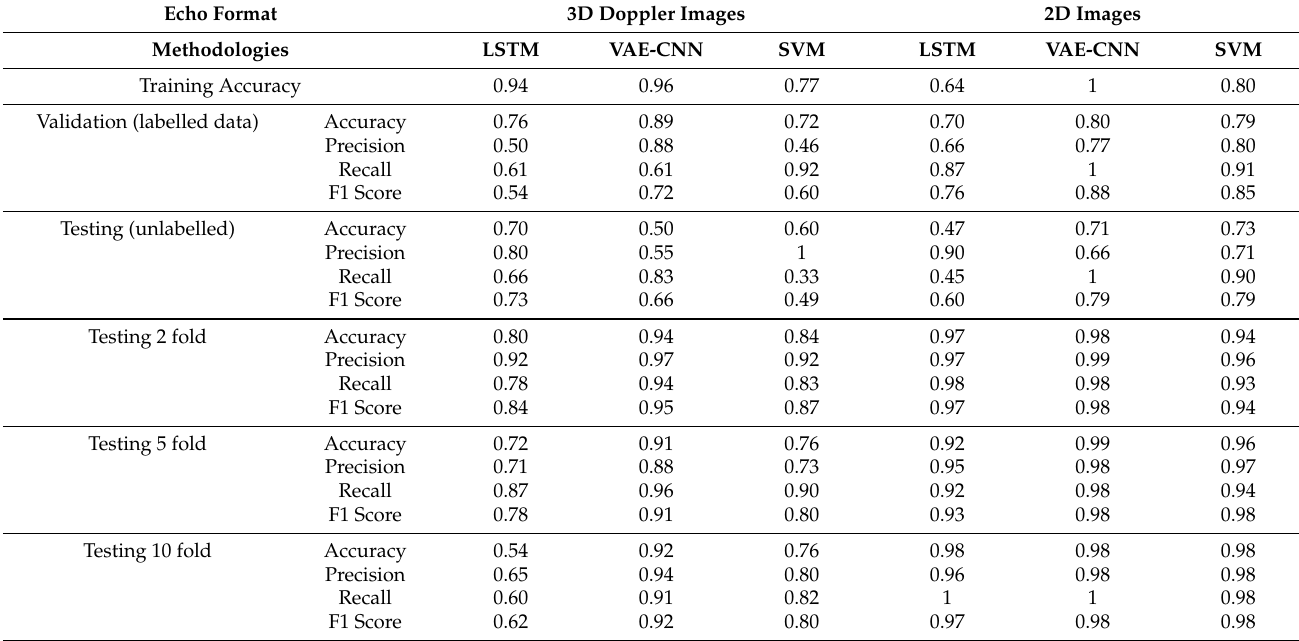
Figure 14. Confusion matrix for 10 fold cross validation of 3D Doppler images for SVM, LSTM and VAE-CNN respectively. Table 2. Output for 2D images and 3D Doppler